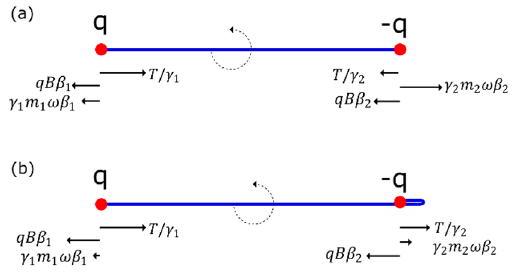
Figure 4 . The forces acting on the endpoint particles when the fold develops. The forces are drawn to scale for a solution with qB/T = 1 / 8 and equal endpoint masses. In (a) we take m/T‘ = 0 . 003 ( T‘ being equal to the energy carried by the string) and we find a solution without a fold. When the masses are taken to be even smaller, m/T‘ = 0.001 then we have only the solution with the